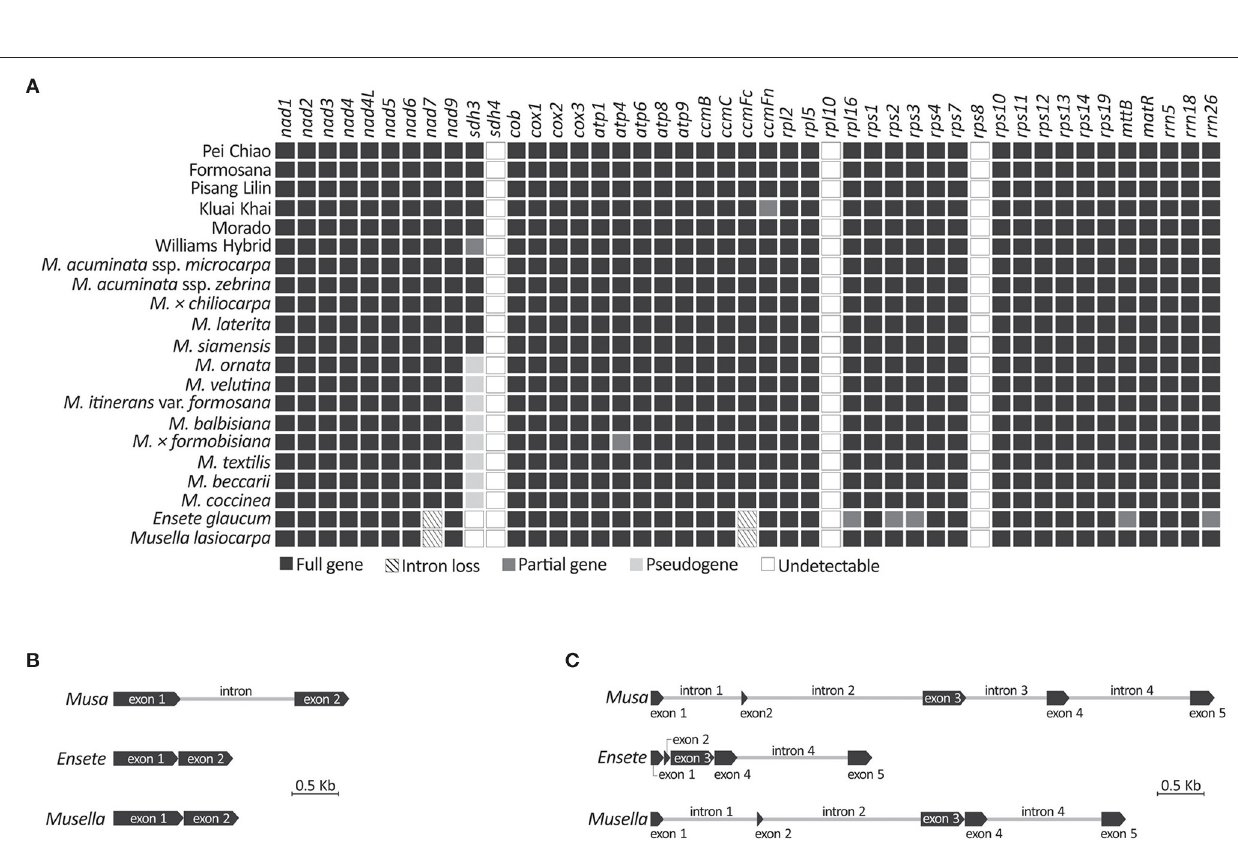
Frontiers in Plant Science |